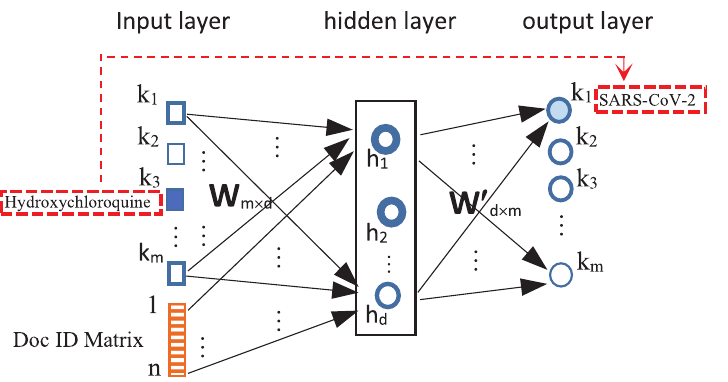
Fig 10. Doc2vec [25] neural network architecture for learning word and document embedding vector. The input dimensions are m (corresponding to the vocabulary of documents) and n (corresponding the the number of documents). The hidden layer has d nodes, representing the embedding feature size. The output dimensions are m (corresponding to the vocabulary of documents). The principle is to learn to predict context. For example, if a report has “hydroxychloroquine” followed by “SARS-CoV-2” in the same sentence, the input corresponding to “Hydroxychloroquine” is set as one, and the Doc ID is also set as one. The network will learn weights to produce the largest output values corresponding to the node